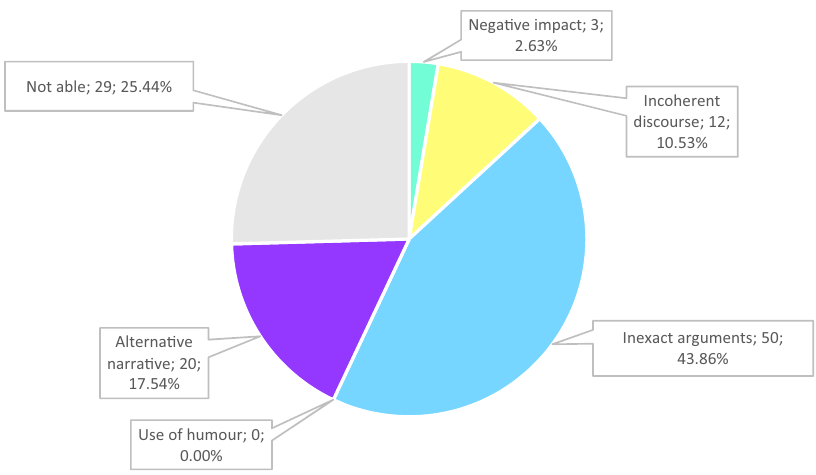
Fig. 2 Future teachers developing counterspeeches. Results of activity 2 classi fi ed